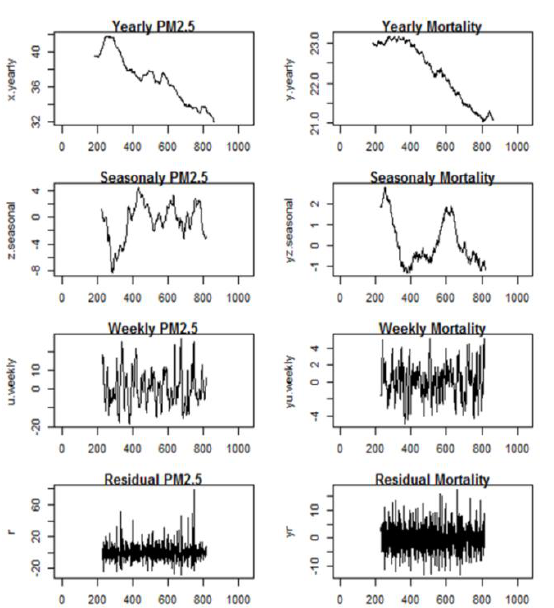
Figure 6. Timescale decomposition for PM